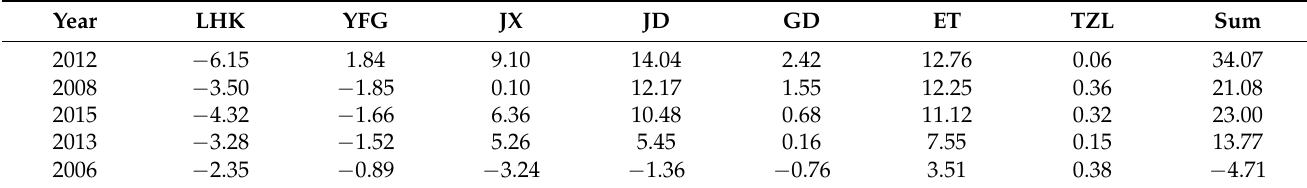
Table 5. Power generation (10 8 kWh) of each reservoir increased by Scheme 3 compared with Scheme 1.